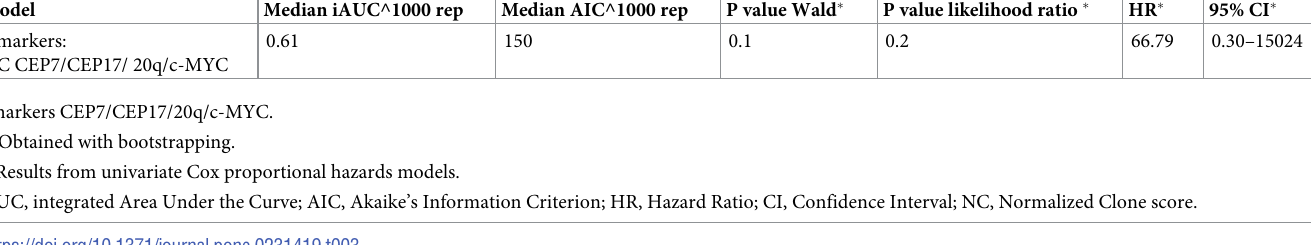
Table 3. Outcomes of the best performing clonal diversity score over set 2 † .